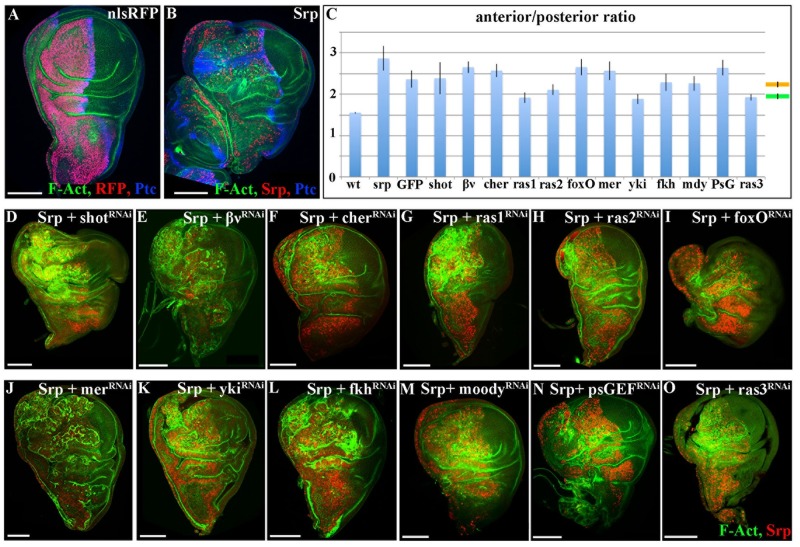
srp-induced overgrowth is partially rescued by RNAis against ras and yki.A, B, D-O 3rd instar wing discs from either control individuals expressing stingerRFP to mark anterior the anterior compartment (A) or individuals expressing the indicated transgenes in the anterior compartment (B, D-O). Discs are stained for F-Act (green), RFP (red) and Ptc (blue) (A); for F-Act (green), Srp (red) and Ptc (blue); and for F-Act (green) and Srp (red) (D-O). Ras1, ras2 and ras3 denote 3 independent RNAi transgenes against ras—see methods. Transgenes are under the control of the ci-Gal4 driver and tub-Gal80TS and the discs are fixed 48 hours after shifting to 29°C. Scale bars—100μm. C Histogram plotting the A/P width ratio of wing primordia expressing either nuclear RFP alone (wt), srp alone (Srp), srp together with GFP (GFP) or srp and dsRNA for the indicated genes under the control of ci-Gal4 driver. Data are presented as mean ± SD. The mean ratio of discs expressing srp and an additional transgene is 2.49 with a standard error of the mean (SEM) of 0.05 and is depicted by the orange line; the mean ratio of discs showing a partial rescue is 1.96 with a SEM of 0.04 and is depicted by the green line. Scale bars—100μm.